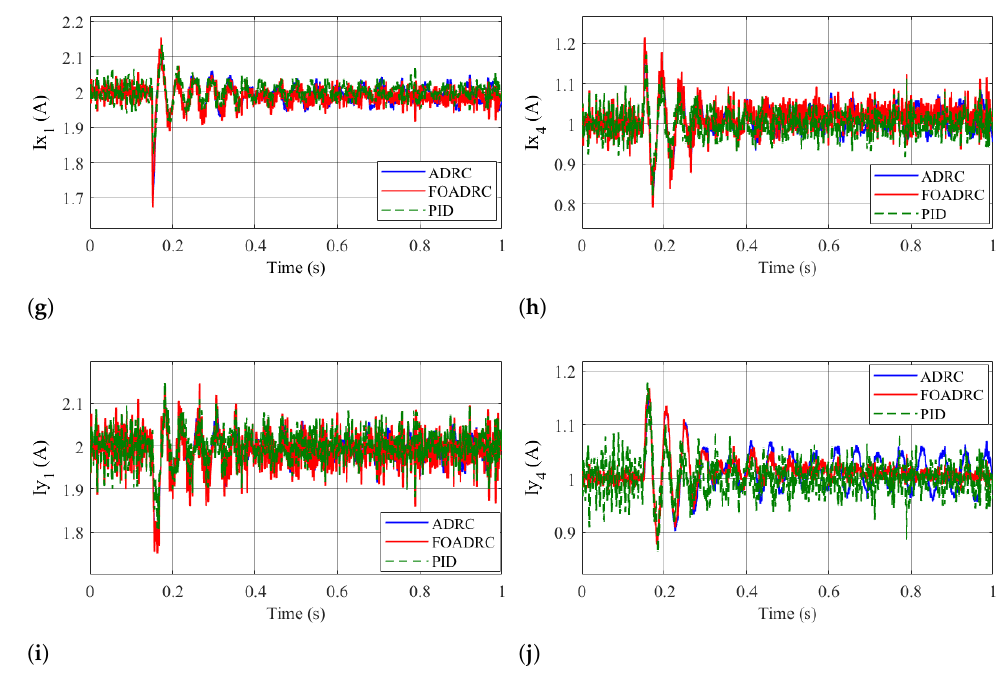
Figure 11. Control currents of the upper coils ( a , c ) and the lower coils ( b , d